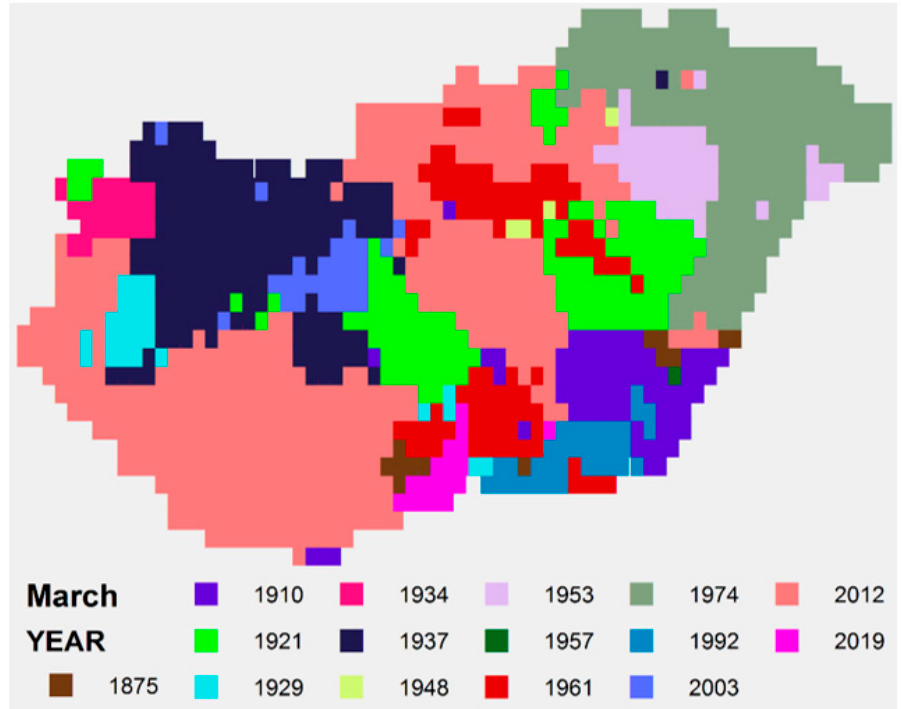
Figure A3. March: Year of maximum SPTI values, 1871–2020.